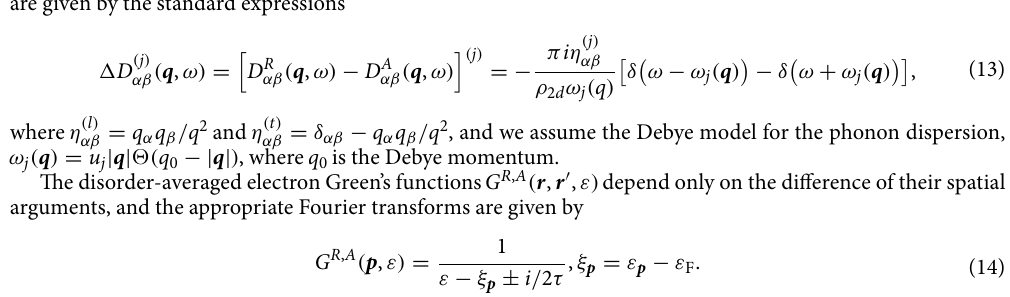
Figure 4. The two lowest-order diagrams that contribute to the collision integral in Eq. (12) due to the interaction of electrons with transverse phonons via impurity scattering: the smaller squares correspond to g the straight lines are the electron Green’s functions, the wavy lines are the phonon Green’s functions and the dashed lines describe the standard averaging over